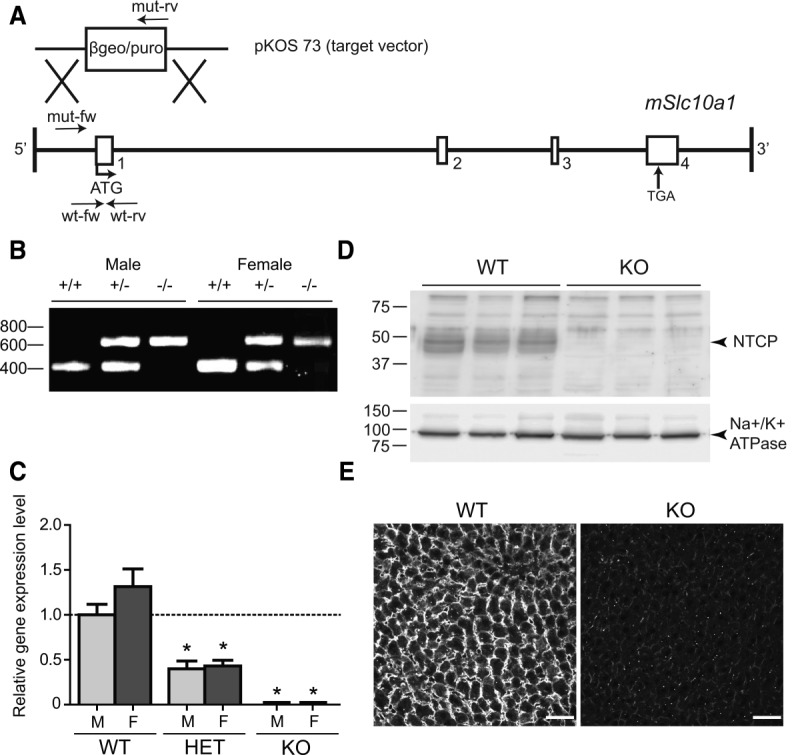
(A) Conventional knockout of Slc10a1 in mouse embryonic stem cells by homologous recombination. A schematic representation of the mouse Slc10a1 gene. Exon 1 was replaced by the β-galactosidase/puromycin (βgeo/puro) selection cassette located in the targeting vector (pKOS 73). Primers of the wild-type allele (wt-fw and wt-rv) and primers of the targeted allele (mut-fw and mut-rv) are shown. (B) Genomic DNA was isolated for genotyping of the offspring mice. Analysis by PCR detected fragments of the Slc10a1 WT (412-bp) and targeted (624-bp) alleles. Homozygous WT (+/+) mice as well as heterozygous (+/−) or homozygous KO (−/−) male and female mice are shown. All PCR products were separated by 1.0% agarose gel electrophoresis. (C) Slc10a1 mRNA expression in female and male WT, heterozygous (HET), and Slc10a1−/− (KO) mouse livers, analyzed by qRT-PCR. Slc10a1 expression values were calculated relative to the geometric mean of Rplp0 and Tbp and normalized to male WT mice (set at 1.0). Data represent mean ± SEM from six or seven male (light gray) or female mice (dark gray). *P < 0.05. (D) Levels of NTCP protein (∼45-50 kDa) in liver plasma membranes of WT and KO male mice (n – 3), analyzed by western blot. Equal volumes of protein were loaded, as confirmed by the sodium/potassium adenosine triphosphatase (∼90 kDa). (E) Immunofluorescent NTCP staining in WT and KO fresh frozen liver tissue. Scale bar – 40 μm.